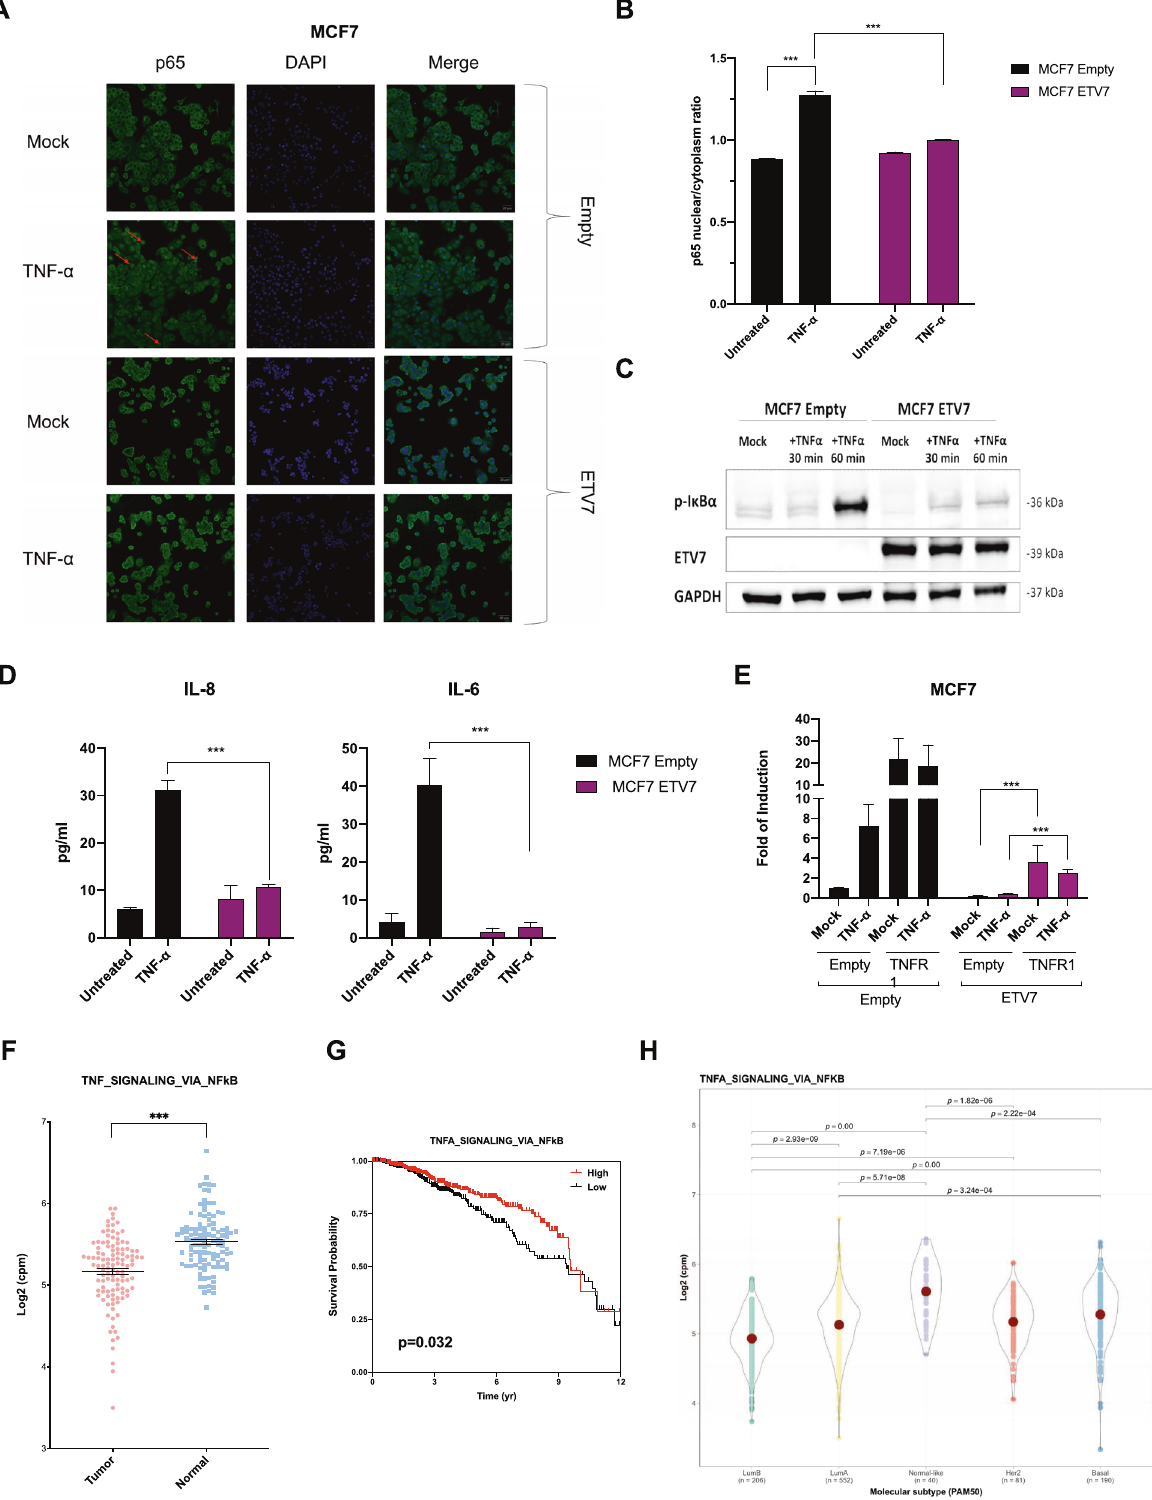
Western blot analysis. Data obtained con fi rmed that the phosphorylated form of STAT3 is mainly located in the chromatin-associated fraction and, as expected, there is an increase in phosphorylated STAT3 in the chromatin compartment in response to the treatment with IL-6 (Fig. 5C and